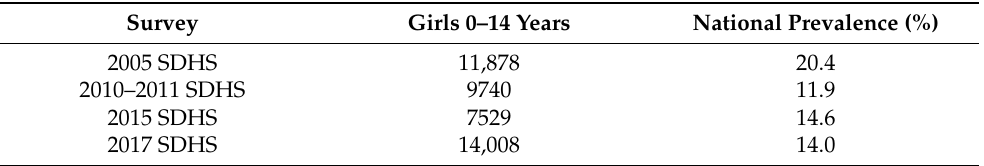
Table 1. Sample size of girls aged 0–14 years for each of the Senegal DHS surveys from 2005 to 2017 as well as the corresponding female genital mutilation/cutting (FGM/C) national